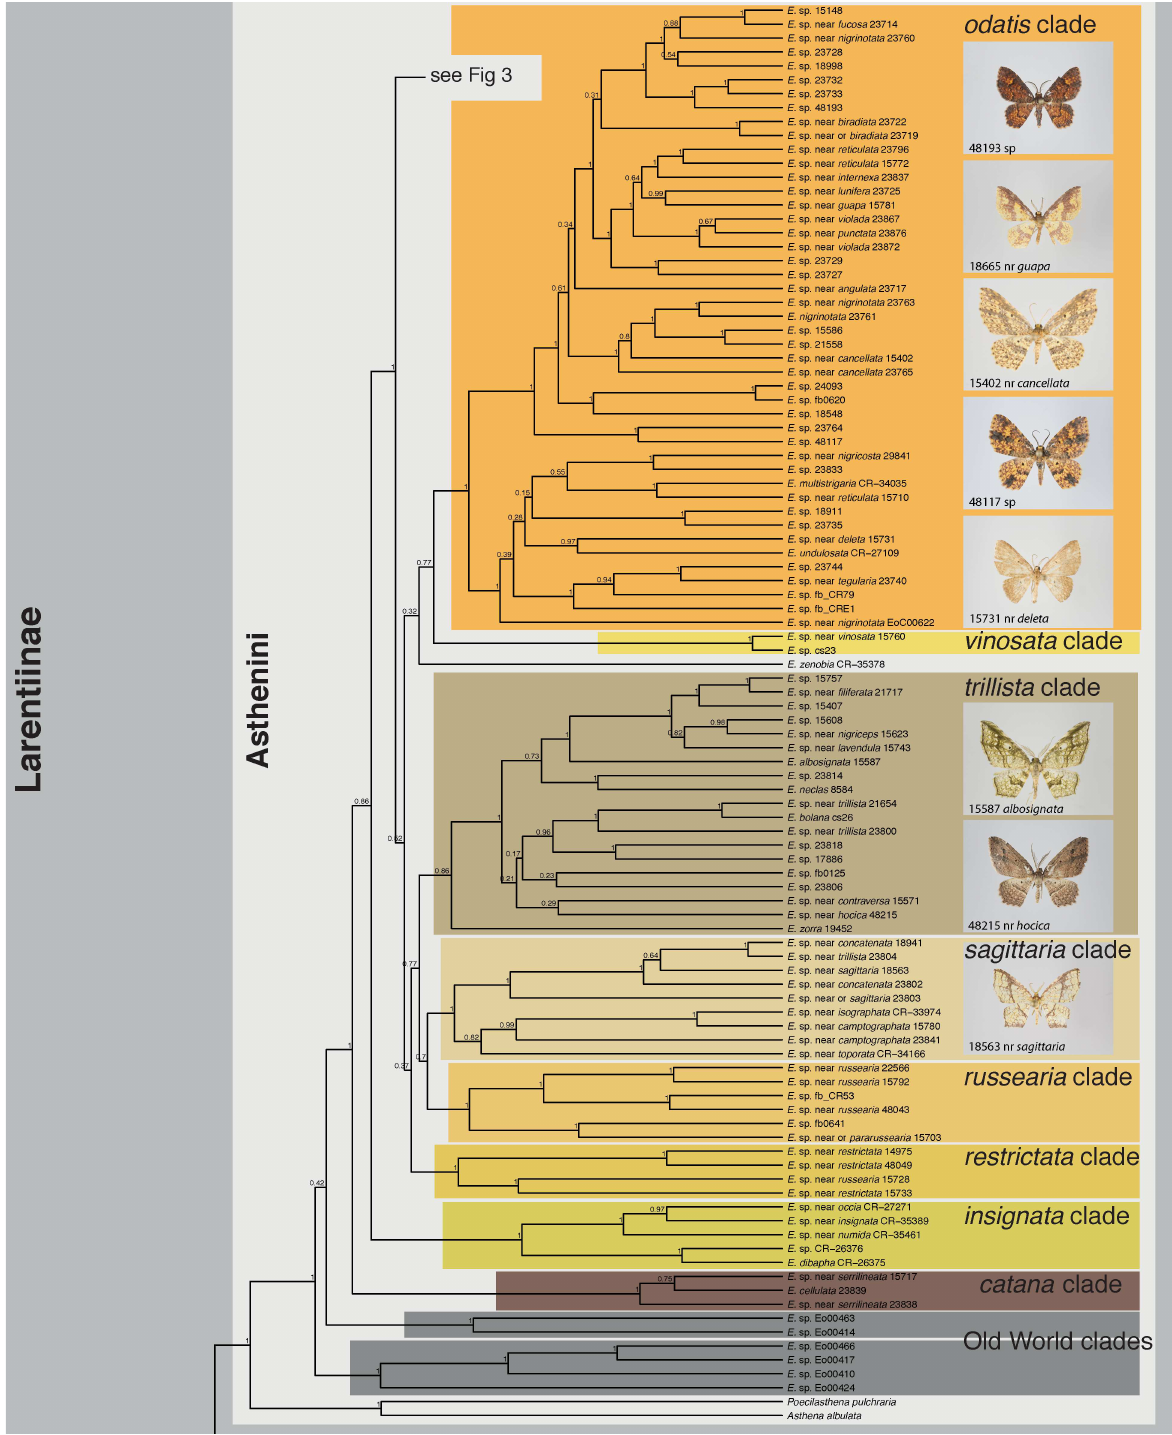
Fig 2. Phylogenetic tree obtained from BEAST, Part 2. All informally named infrageneric clades are indicated along with photographs of select members of each clade within Neotropical Eois . Bayesian posterior probabilities are given at nodes.